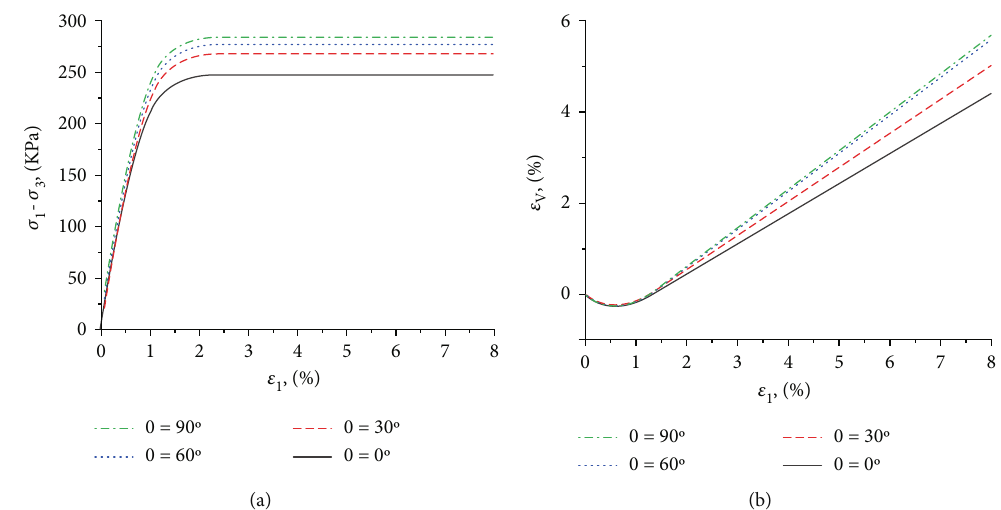
Figure 9: Simulation of triaxial tests for various bedding angle: (a) deviatoric stress vs. axial strain; (b) volumetric strain vs. axial strain. 01.001.011.021.03